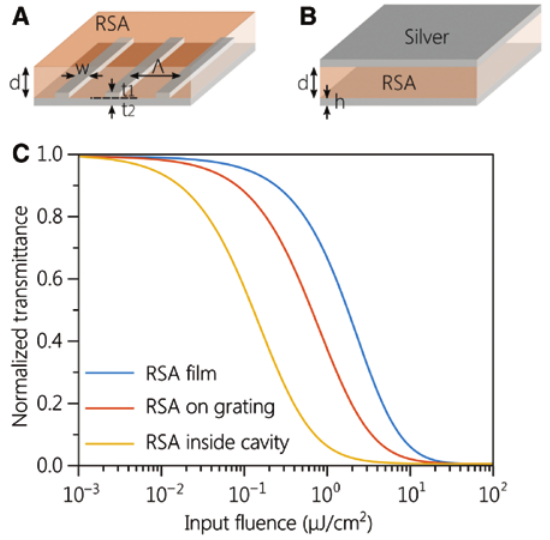
Figure 5: Enhancement of OLs using plasmonic structures. RSA thin film of 200 nm thickness (A) coated on top of a silver grating and (B) sandwiched between two thin silver layers. (C) Normalized transmittance vs. pump fluence for all three configurations: bare RSA thin film, the same film on top of a silver grating, and same RSA film between two thin silver